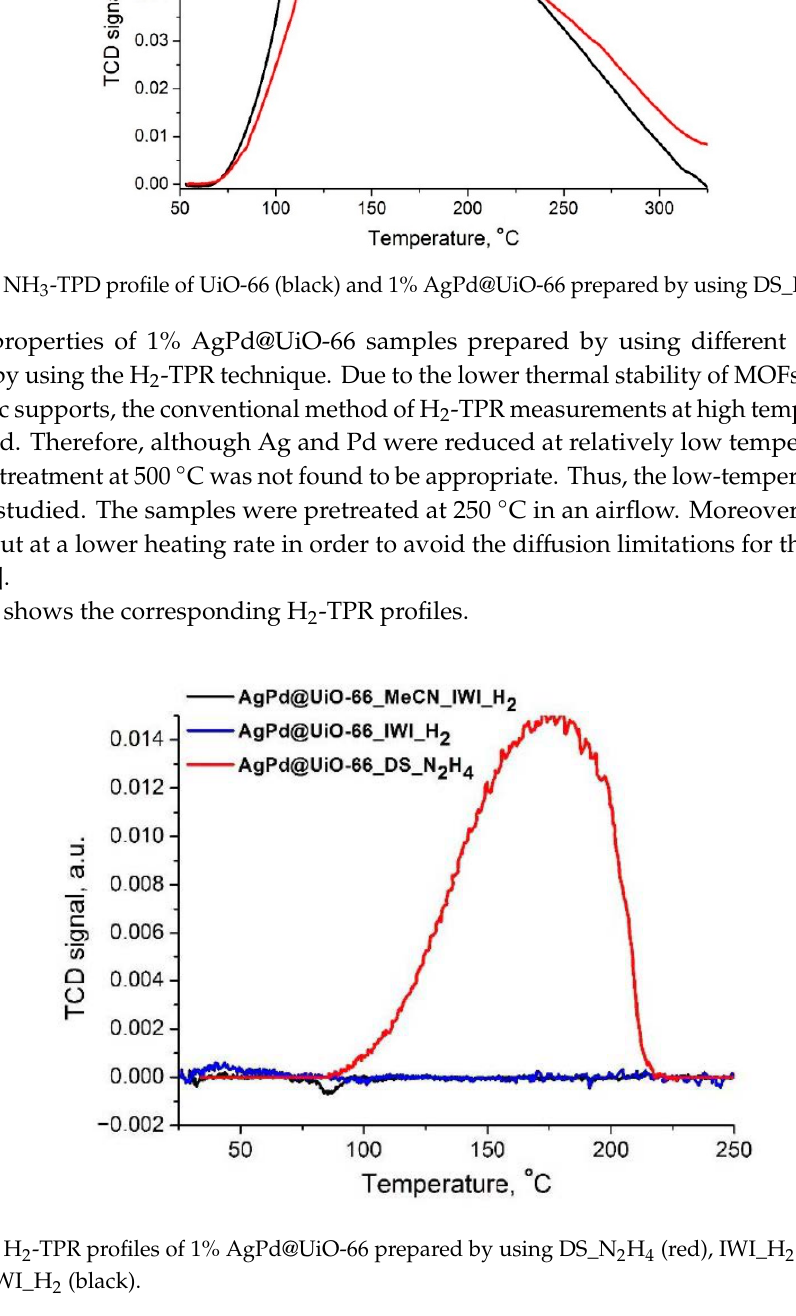
Figure 6. H 2 -TPR profiles of 1% AgPd@UiO-66 prepared by using DS_N 2 H 4 (red), IWI_H 2 (blue), and MeCN_IWI_H 2 (black).